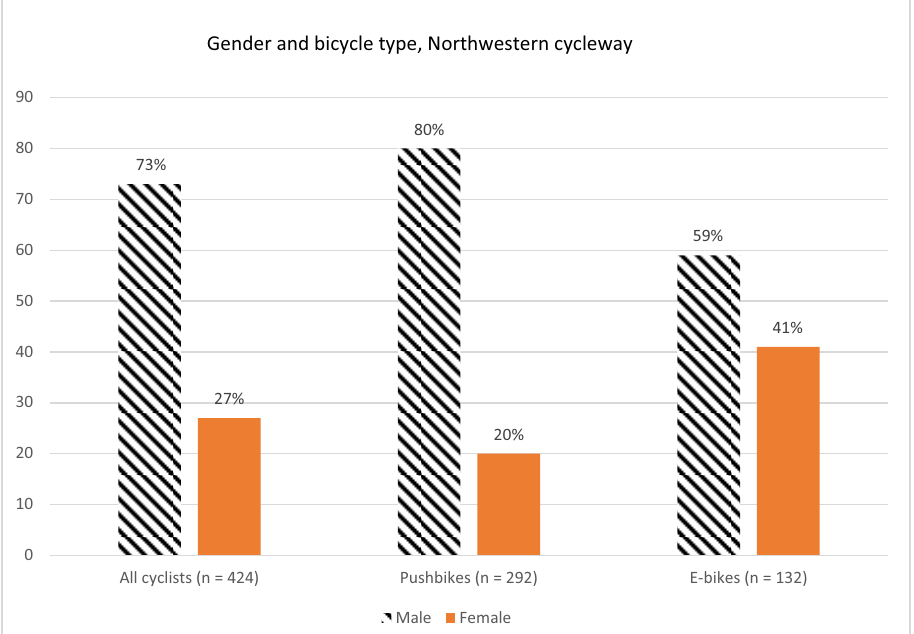
Figure 1: Gender and bicycle type, Northwestern cycleway, Auckland, March